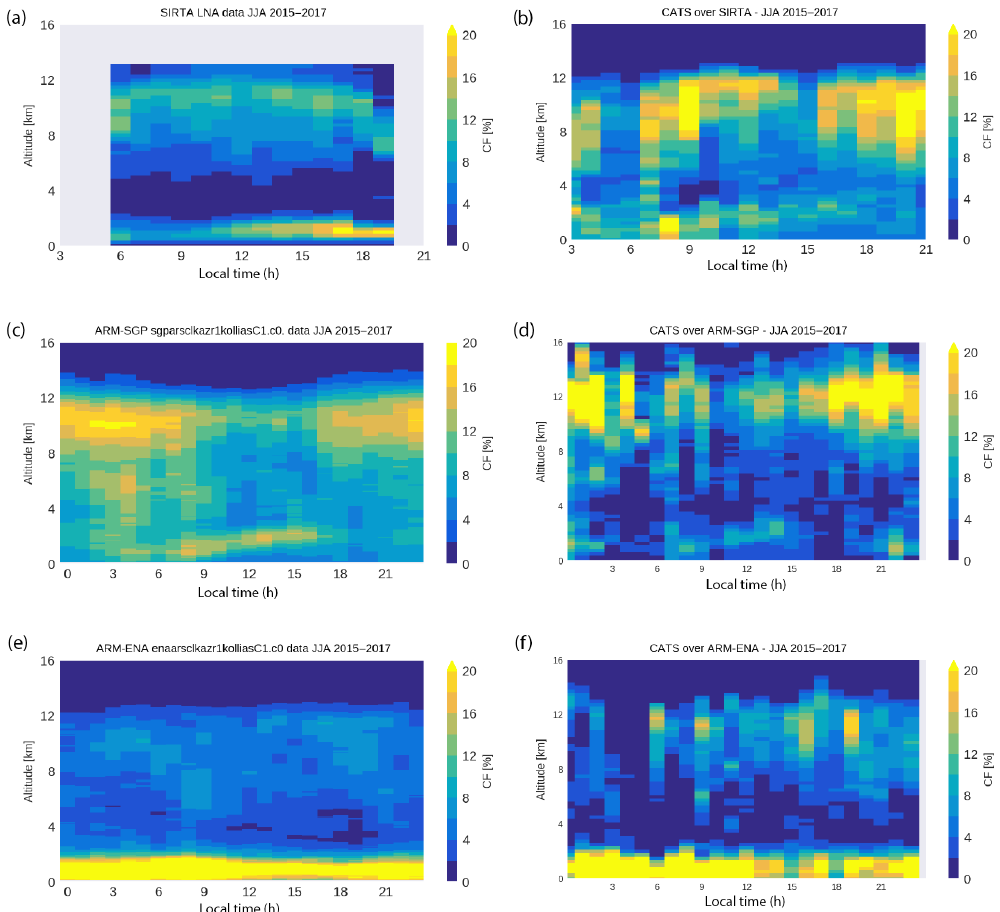
Figure 4. The diurnal cycle of cloud fraction profiles as seen by ground-based instruments (see text, a, c, e ) and the CATS instrument (b, d, f) during JJA 2015–2017 at or in a 10 ◦ × 10 ◦ latitude–longitude box centered on (a, b) SIRTA, considering only sunlit conditions; (c, d) ARM-SGP; and (e, f) ARM-ENA. Times are